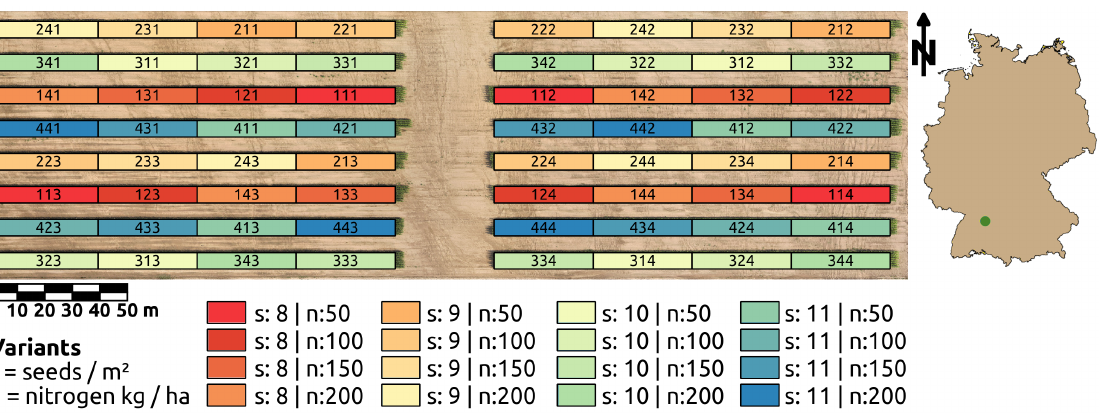
Figure 1. Overview of the two-factorial field trial in corn with 64 plots of a size of 36 × 6 m each. Four sowing densities (8–11 seeds · m − 2 ) were tested at four different levels of nitrogen fertilization (50, 100, 150 and 200 kg · N · ha − 1 ) in a setup with four